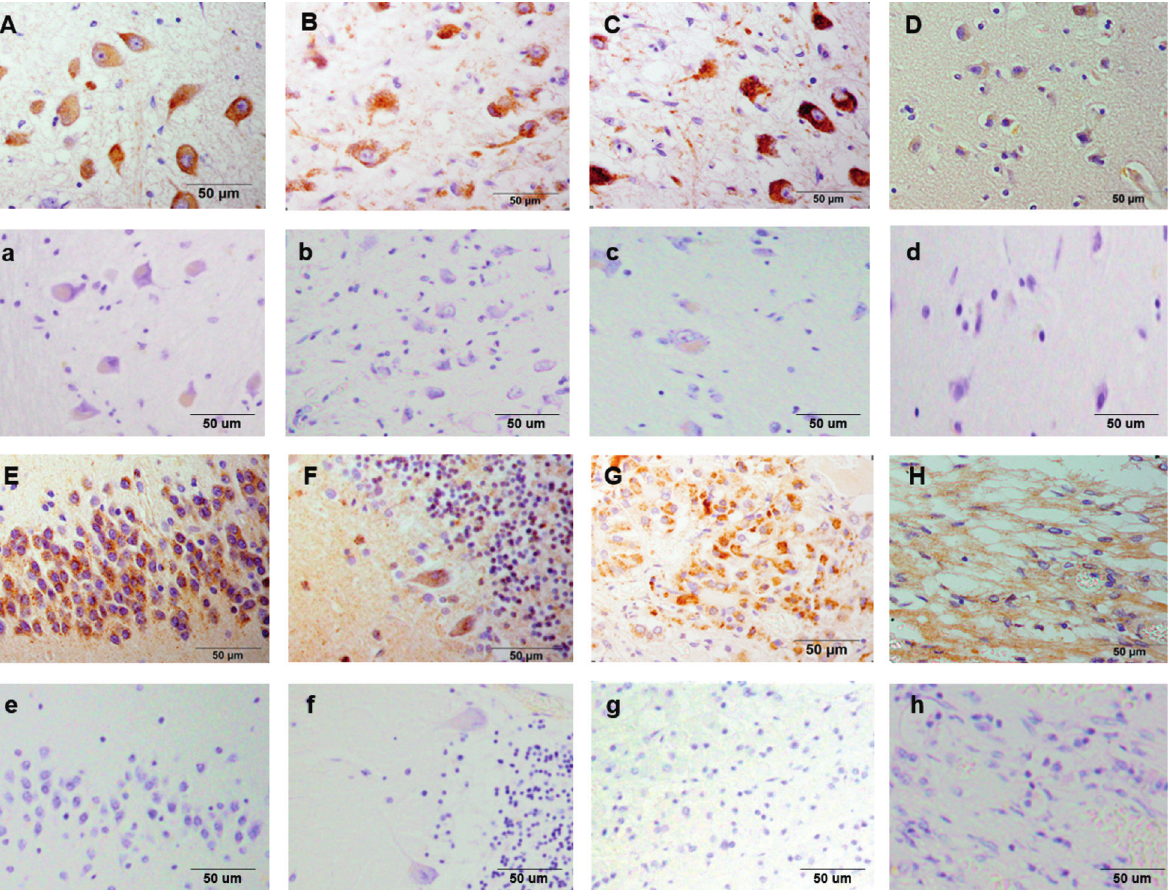
Figure 2: (Pro)renin receptor staining in brain lesions. (A) Nucleus tractus solitarii; (B) paraventricular nucleus of the hypothalamus; (C) supraoptic nucleus of the hypothalamus; (D) cerebrum; (E) granular layer of the hippocampus; (F) Purkinje cell layer of the cerebellum; (G) anterior lobe of the pituitary gland; and (H) posterior lobe of the pituitary gland. (a–h) Negative controls in the organs mentioned.